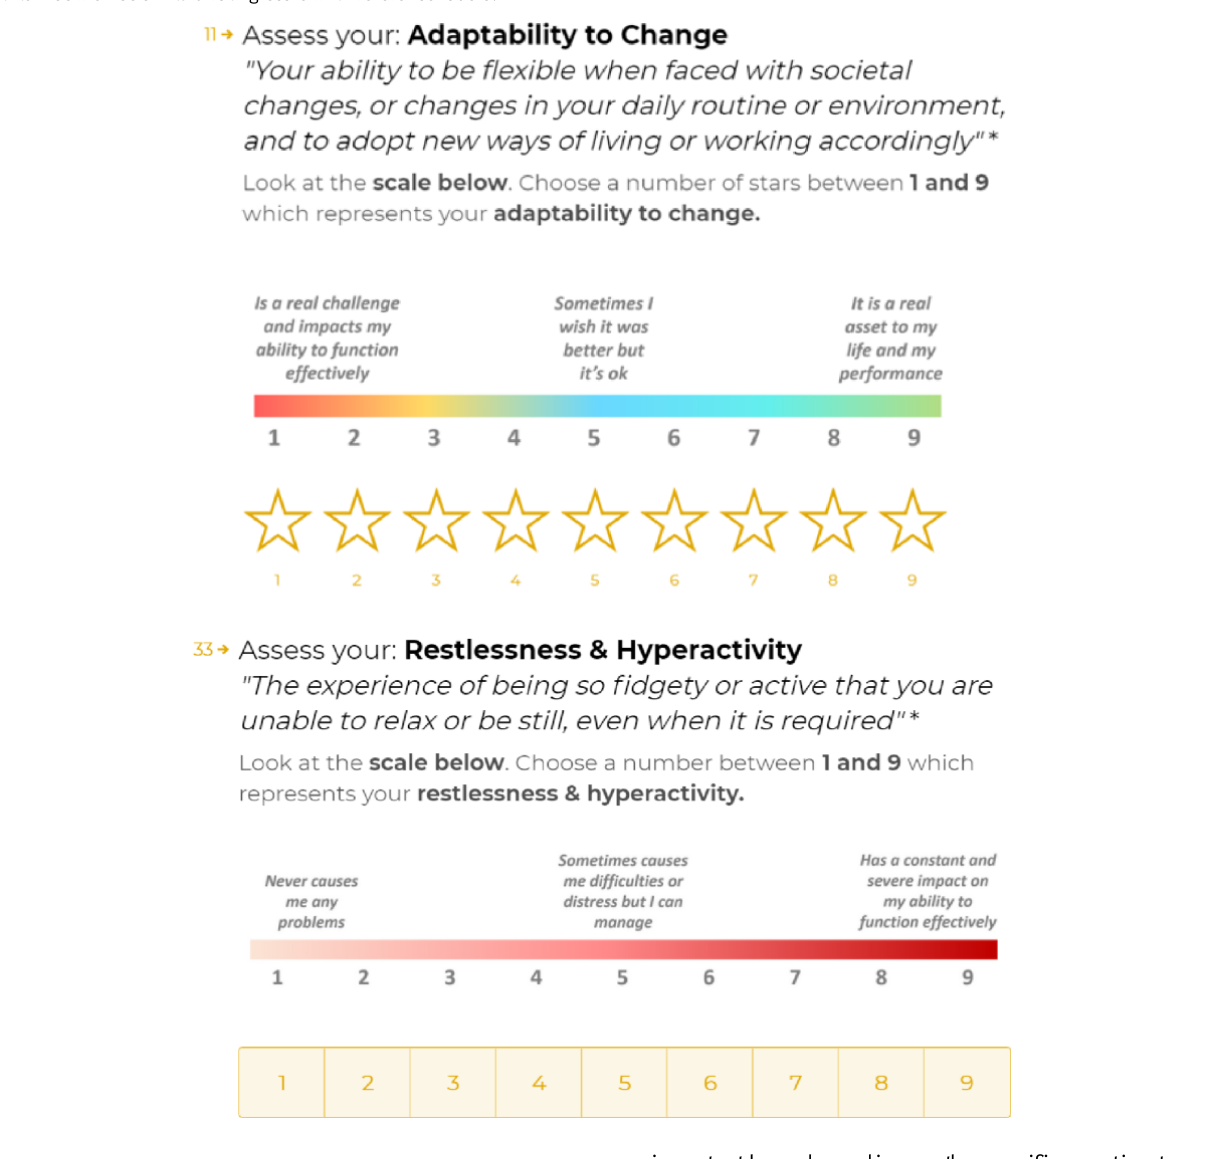
Figure 2. Example of a spectrum question and a problem question. Each question was composed of an item category and a 1-sentence description of that item as well as a 1 to 9 rating scale with reference